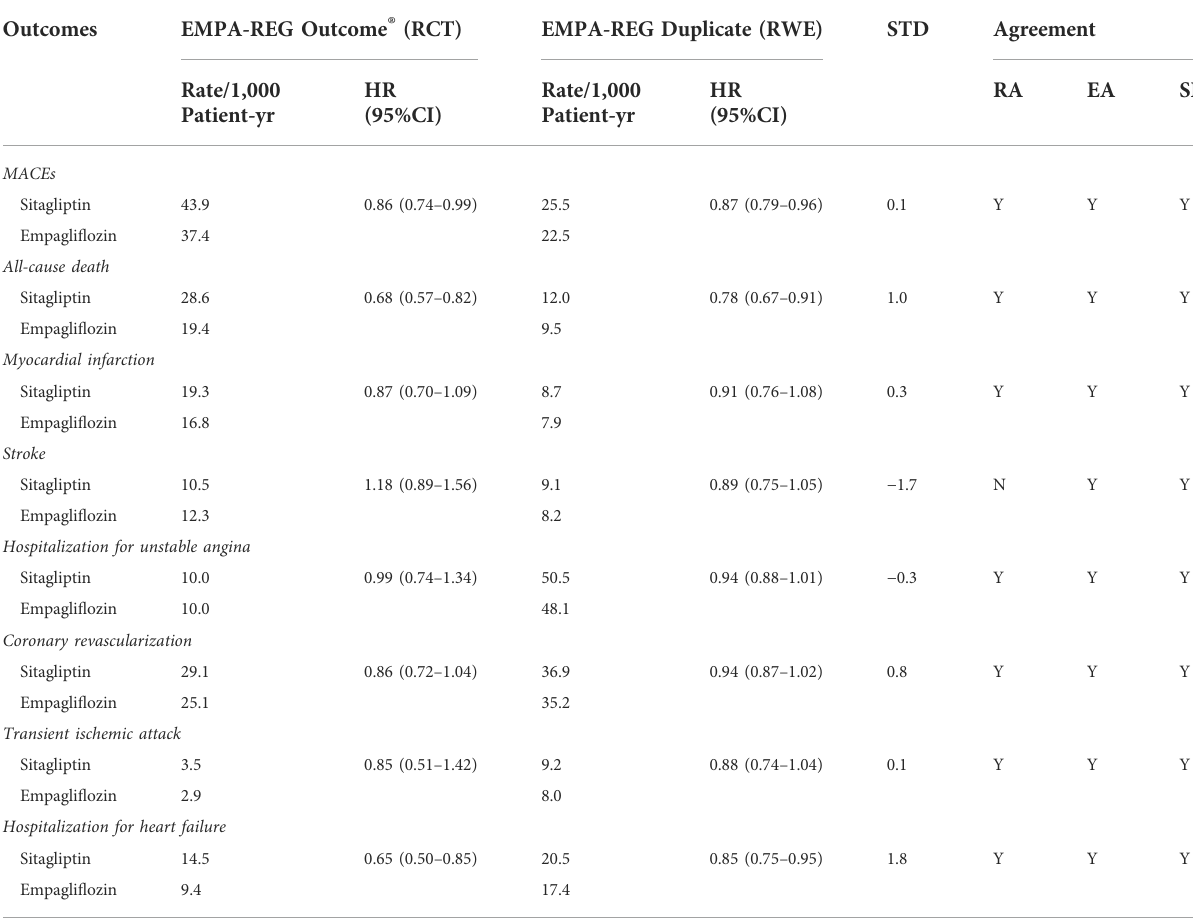
TABLE 3 RCT-RWE agreements for MACEs and each cardiovascular outcome component.